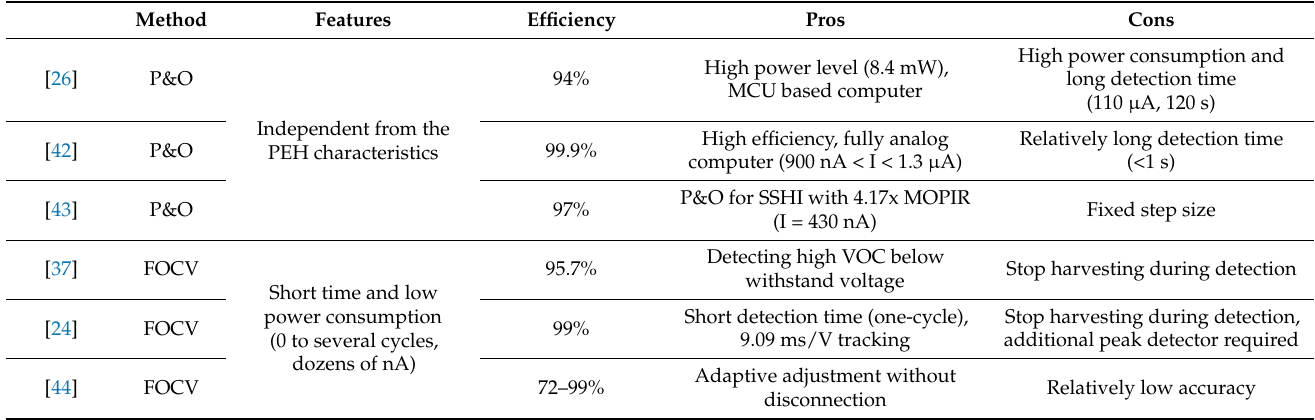
Table 4. Comparison of the MPPT circuits based on the P&O and the